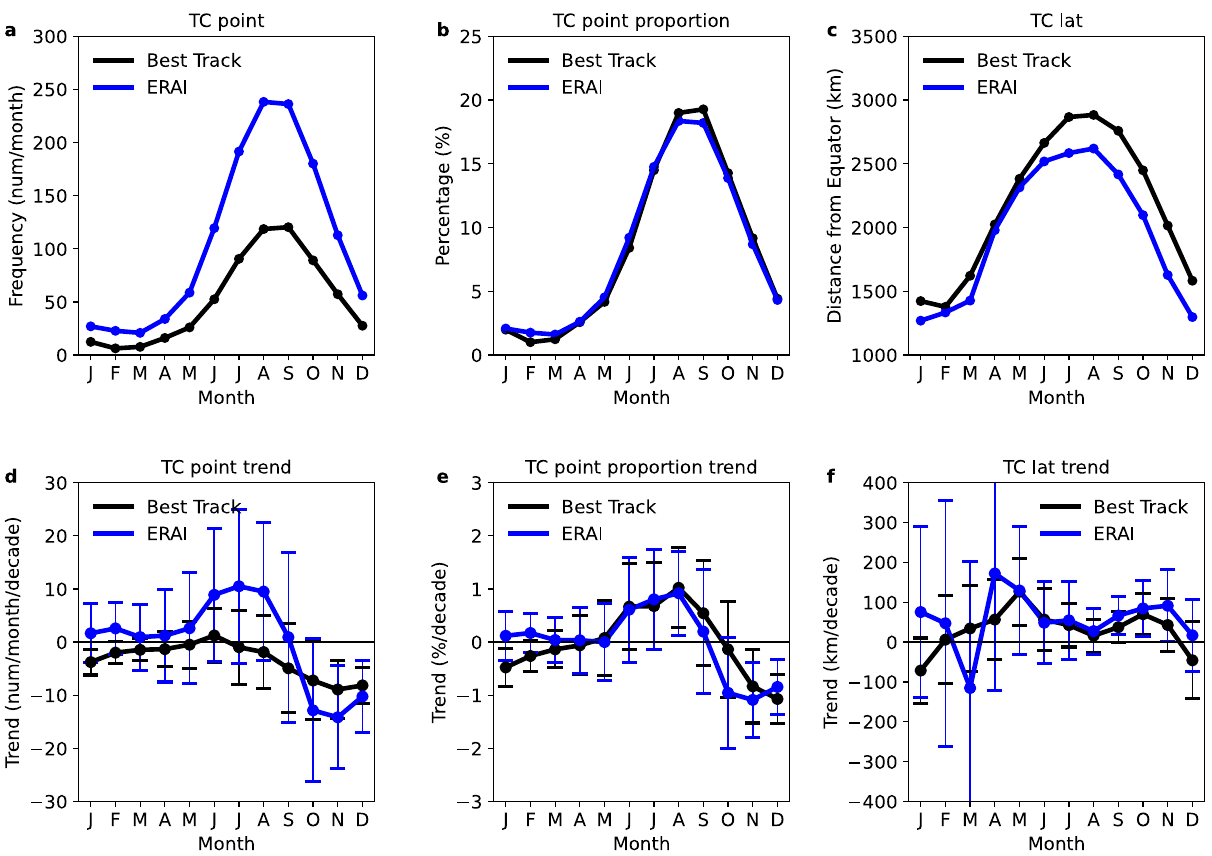
Fig. 2 Seasonality of tropical cyclone all-track-points, and changes in seasonality. a – c Climatology of 3-month rolling averages of monthly frequency, monthly relative frequency and monthly latitude for all-track-points, over 1979 – 2018, in the Best Track ensemble mean (black) and ERA-Interim (blue) TC datasets. d – f Linear trends in 3-month rolling averages of monthly frequency, monthly relative frequency, and monthly latitude for all-track-points, over 1979 – 2018, in the Best Track ensemble mean (black) and ERA-Interim (blue) TC datasets. In c , f , latitude is converted to distance from the equator (km); in the lower panels, the error bars show 95% con fi dence interval for the trends; the El Niño Southern Oscillation and Paci fi c Decadal Oscillation effects are removed by a multivariate